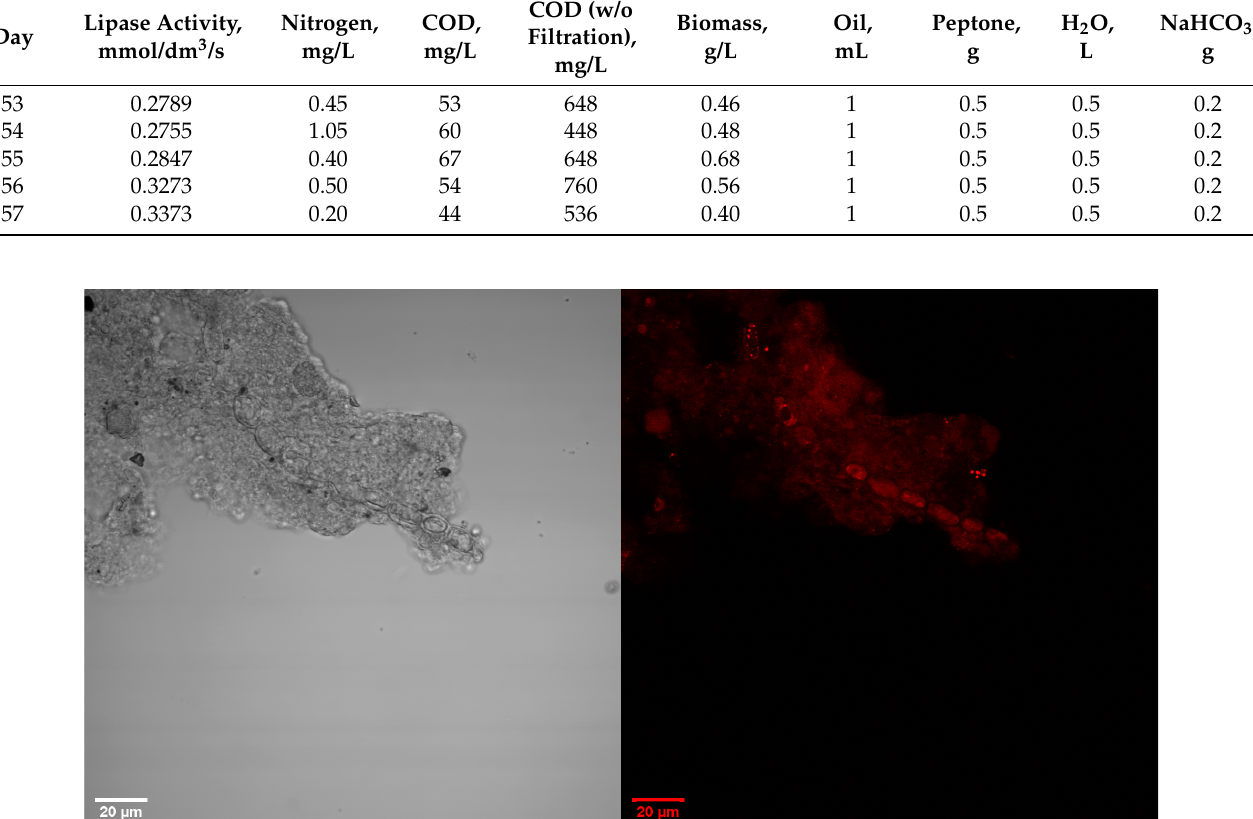
Figure 13. Microscopic images (objective 60×) of the sample (continuous reactor) observed in visible light and after using Nile Blue A procedure with red filter and blue laser excitation. The photo was taken on day 53 of continuous process.